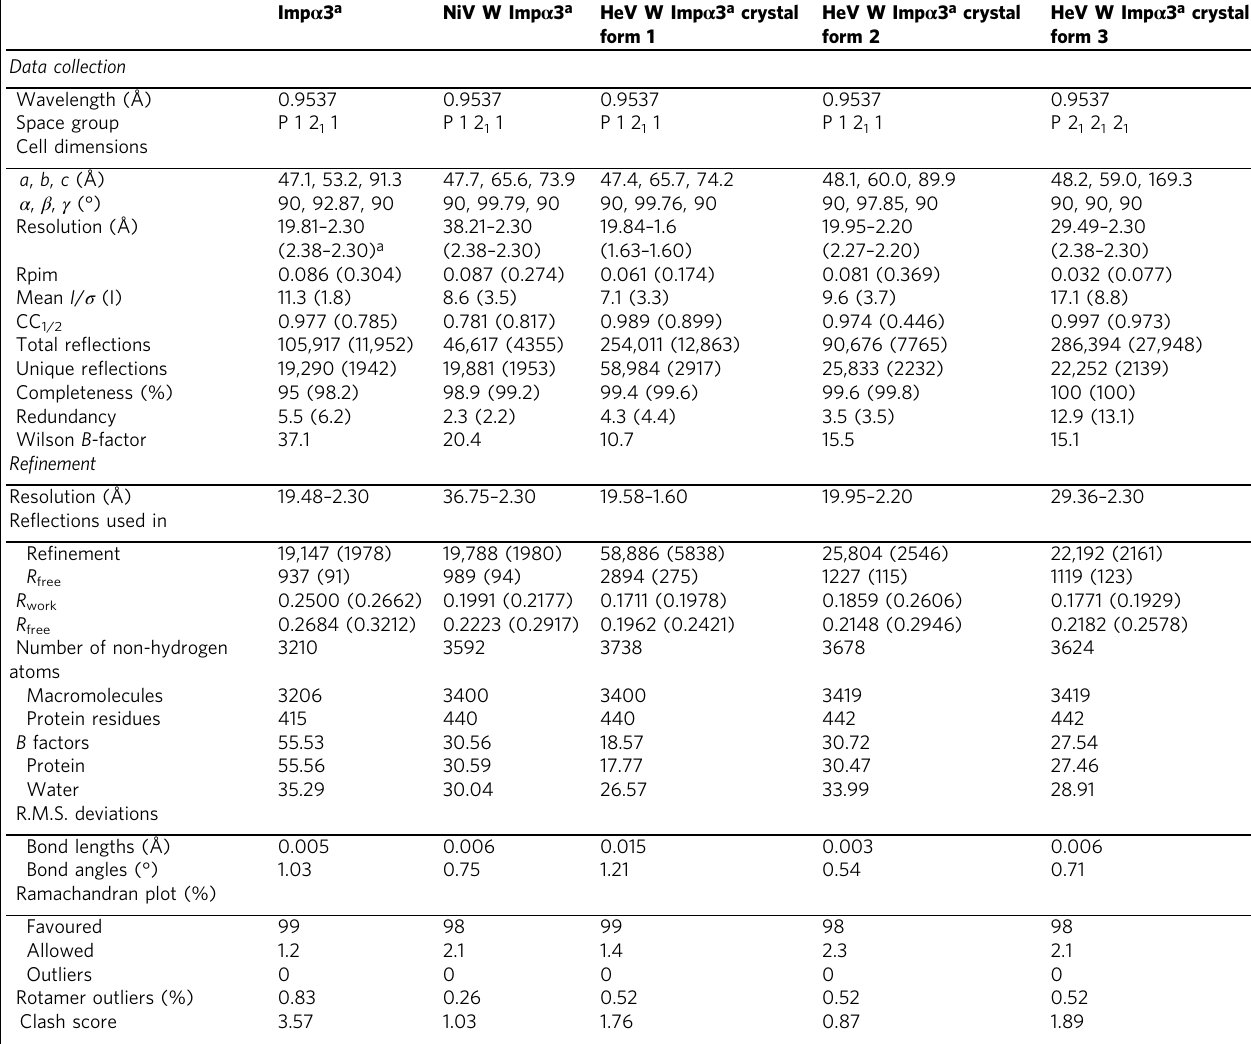
Table 2 Data collection and re fi nement statistics for importin α 3